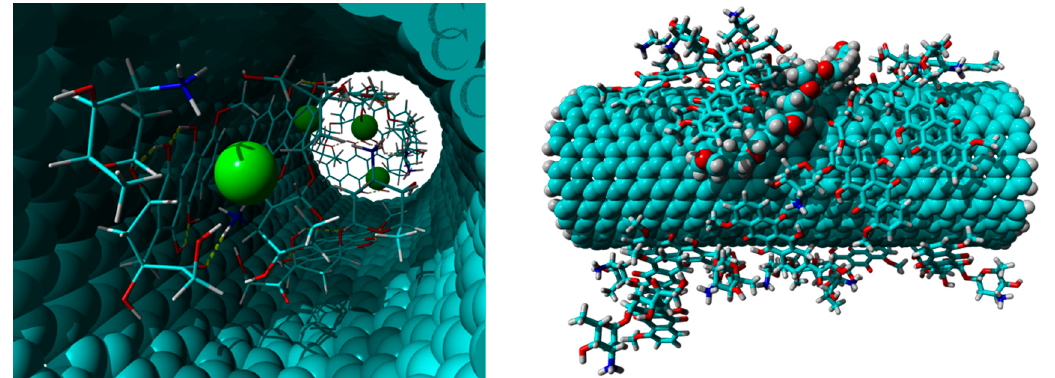
Figure 16. Left: view of the DOX molecules and the chloride ions contained inside the SWCNT cavity of the SSy2 at the end of the 100 ns of the MD simulation; right: view of the DOX molecules and the PPG pendant anchored to the external wall of the SWCNT of the SSy2 at the end of the 100 ns of the MD simulation.